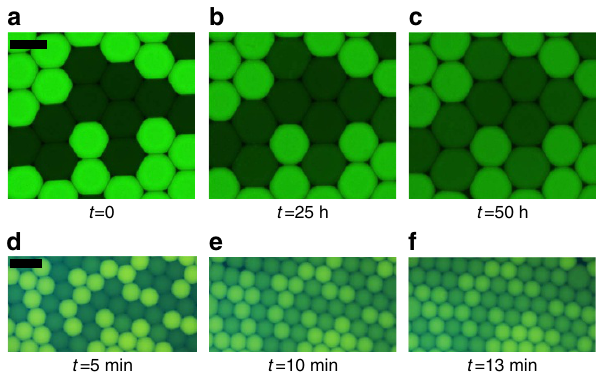
Figure 2 | Molecular transport for two fluorophores. Fluorescein ( a – c ) is exchanged at a time scale of order several days in a water-in-fluorinated oil emulsion stabilized by a PFPE–PEG–PFPE surfactant (in HFE-7500). At production, the bright droplets contain Fluorescein at 100 m M in PBS water and the dark droplet PBS only. In contrast, Rhodamine 6G ( d – f ) is exchanged over minutes (scale bar, 100 m m). At production, the bright droplets contain Rhodamine 6G at 100 m M in millipore water and the dark droplet millipore water only. Resorufin is an intermediate case with a time scale of exchange of the order of 1h (ref.